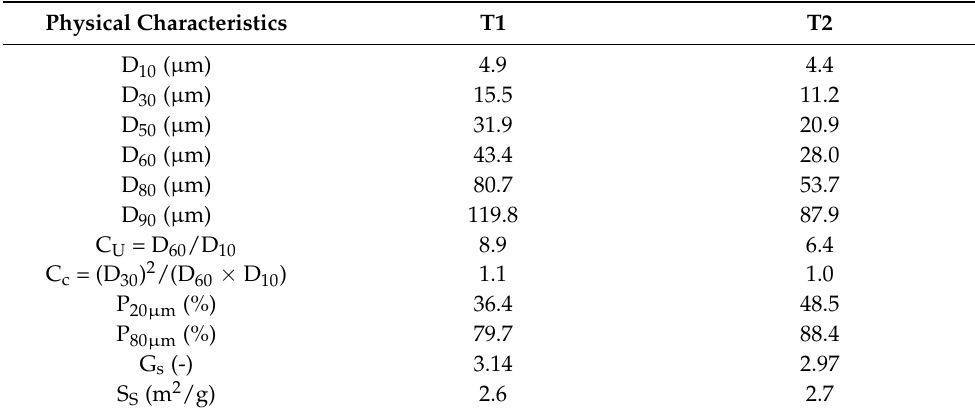
Figure 1. Grain-size distribution curves (cumulative volume percentage) for tailings T1 and T2. Table 1. Physical characteristics of tailings T1 and T2.